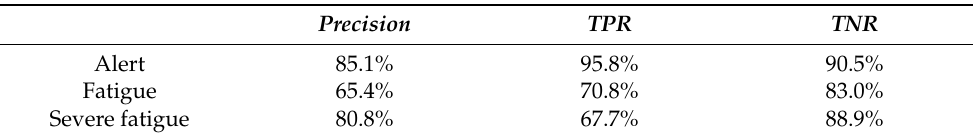
Table 9. BP neural network algorithm evaluation (the test results when the test accuracy reaches the